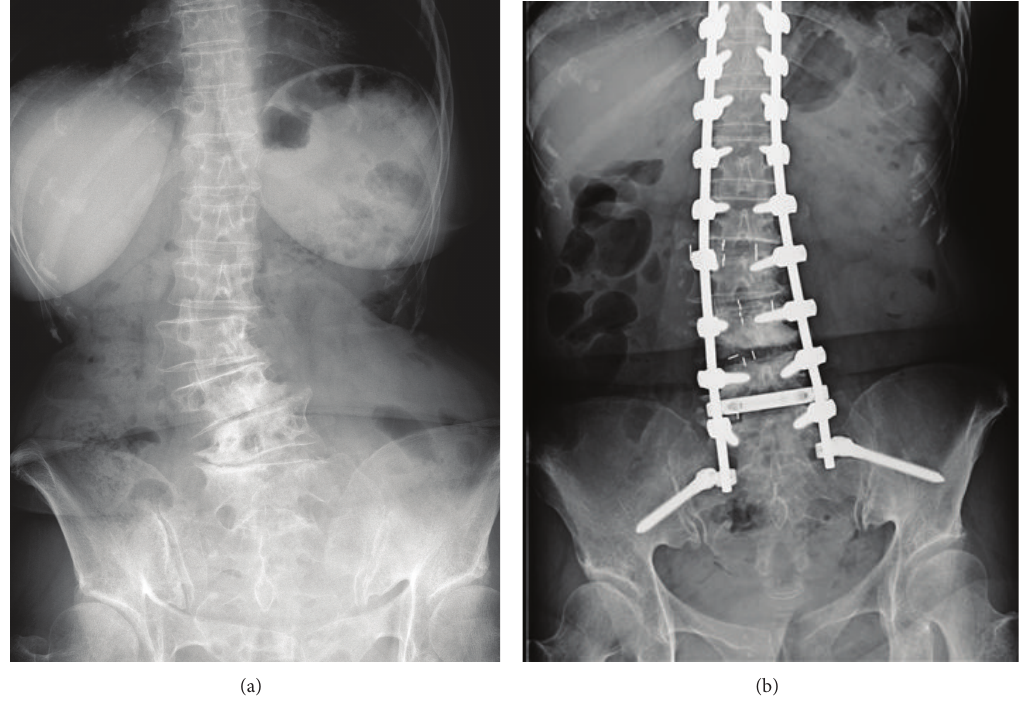
Figure 4: Magnification of X-ray film images of lumbar spine before and after surgery in Case 2. Anterior-posterior view (a) before surgery, and anterior-posterior view (b) after surgery.